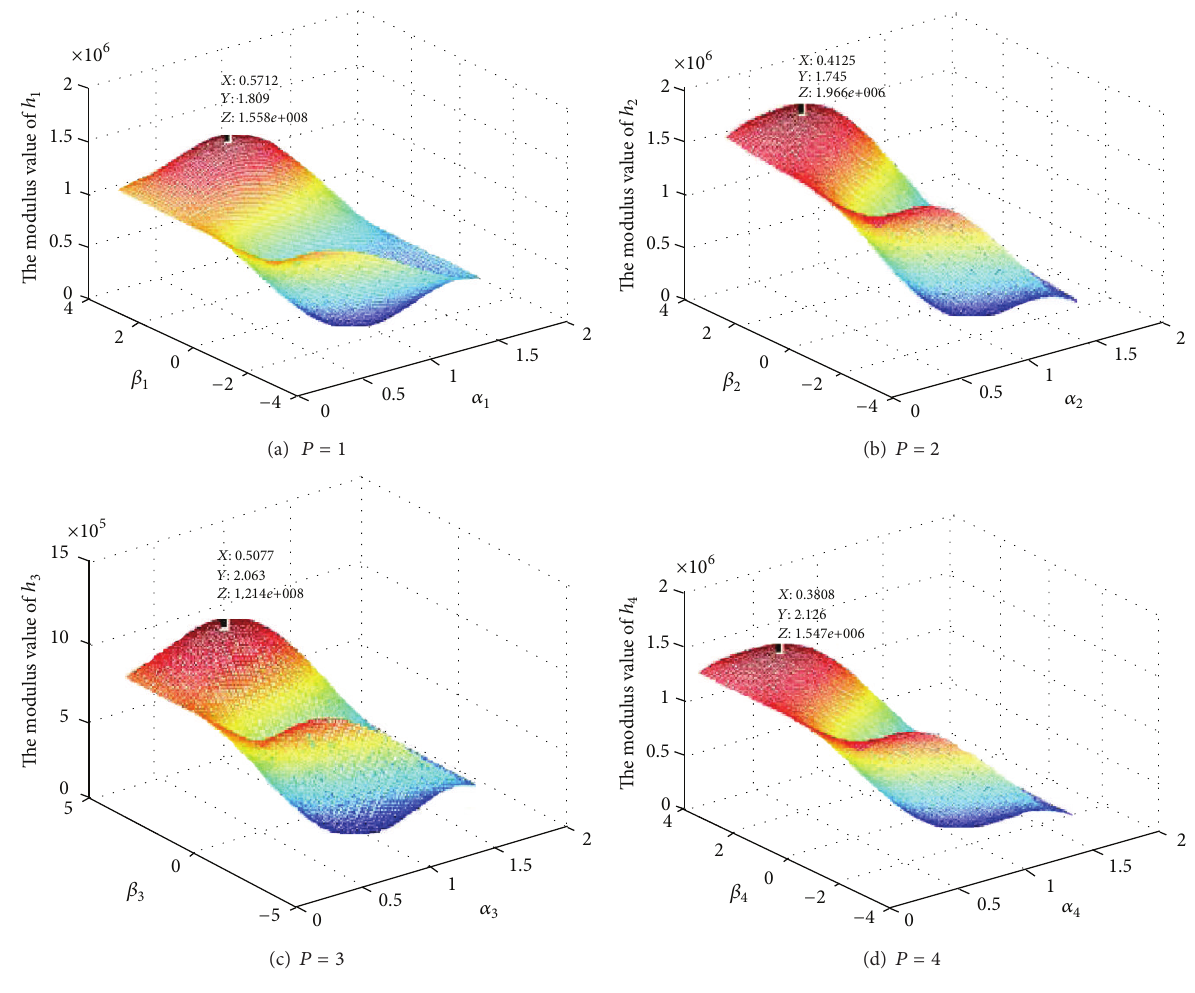
Figure 5: The distribution of modulus value of h .